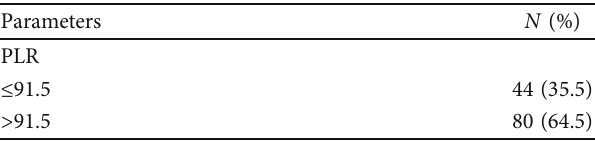
Table 1: Patient characteristics. Table 1: